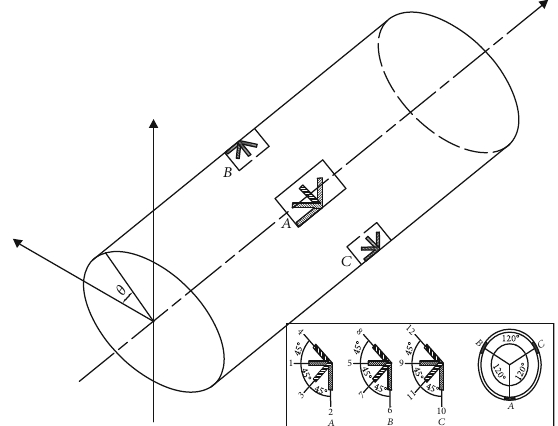
Figure 2: Strain gauge distribution of CSIRO.